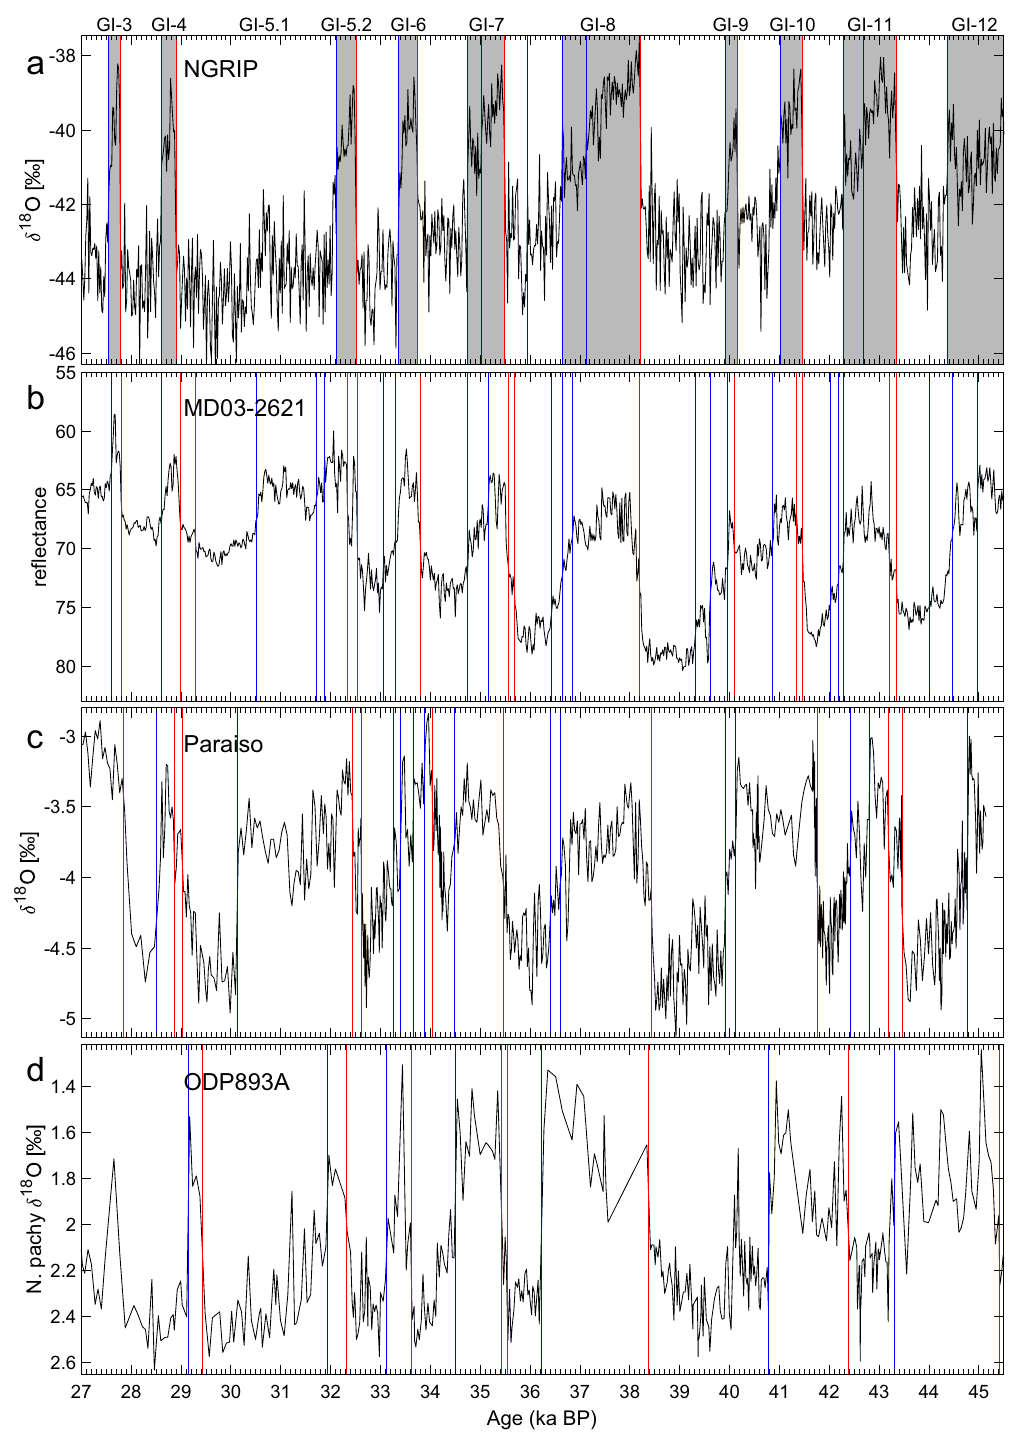
18 Figure 6. Comparison of four paleorecords over the 45.5–27 ka BP interval: ( a ) NGRIP ice core δ O 131 ; 18 ( b ) MD03-2621 marine sediment reflectance 64 ; ( c ) Paraiso Cave (PAR07) δ O 165 ; and ( d ) ODP893A marine 18 sediment N. pachyderma δ O 87,88 . Vertical lines represent detected transitions, with colors indicating the 18 direction of the jumps. Grey bars in panel ( a ) represent interstadials identified for the NGRIP δ O record by Bagniewski et al. 19 . Note that the “ka BP” time unit, where the ‘Present’ is defined as the year 1950, applies only to the Paraiso and ODP893A records. The NGRIP and MD03-2621 records use the “ka b2k” time scale, where ‘b2k’ refers to the year 2000 as the origin of past times. The vertical axes in ( b, d ) are